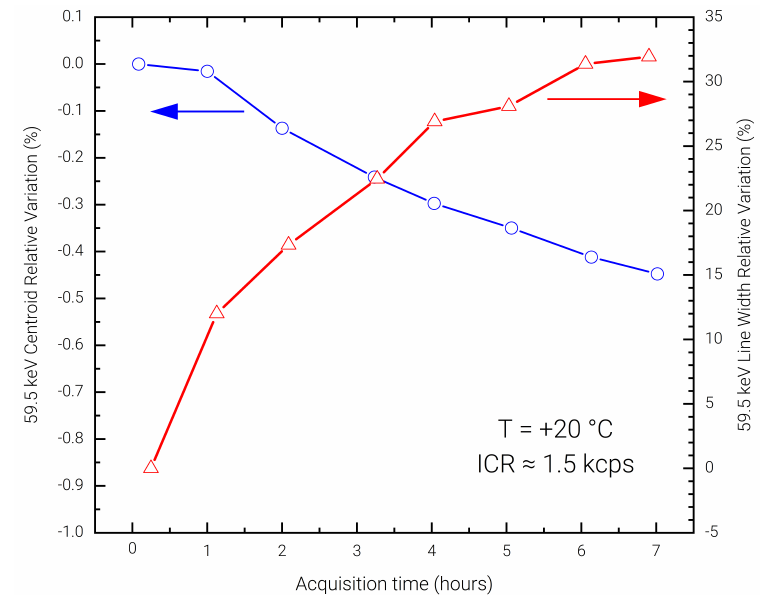
Figure 9. Measured relative centroid shift and FWHM degradation on the 59.5 keV photo-peak over 7-h acquisition time.